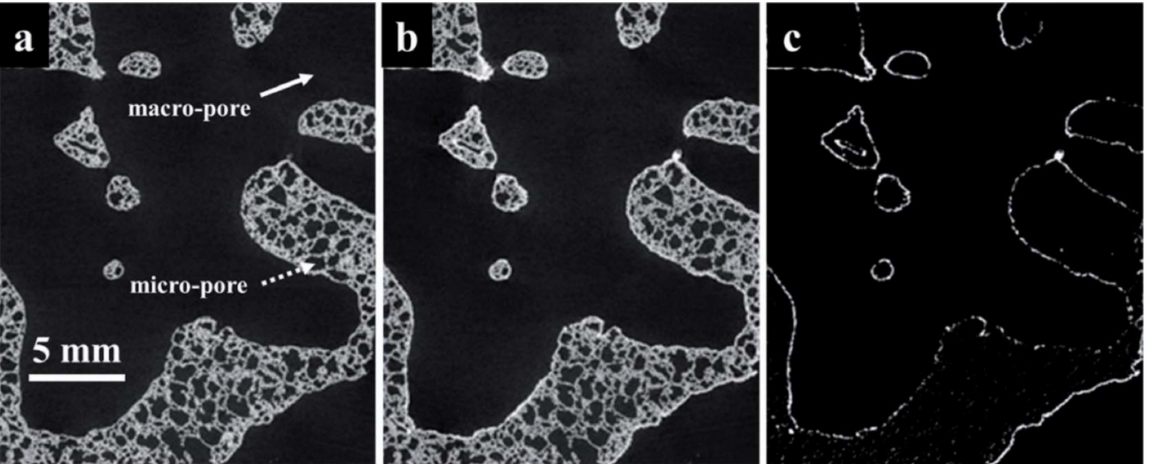
Figure 12. The 2D tomogram slices of a porous SiC sample with dual-scale pore sizes including macro pores between struts and µ m-sized micropores inside struts; ( a ) before; ( b ) after LCMA perovskite coating; and ( c ) after tomograms’ registration showing the perovskite mapping [136]. Haeussler et al. [73] tested a series of ceria RPCs with gradient pore sizes in the range of 10–60 ppi within a 1.5 kW th directly irradiated solar reactor. The temperature-swing RedOx reactions were performed (TR: 1400–1450 ◦ C and WS/CDS at 700–1100 ◦ C) to produce pure H 2 or CO inside the same reactor (Figure 13). Similarly, the results demonstrated that the degree of ceria reduction increases with decreasing of both the temperature and the operating pressure. Moreover, it was found that the oxidation rate could be improved (up to 9.3 mLg − 1 min − 1 ) by increasing the inlet CO 2 flow rate which is attributed to the increasing of the reactions driving force. A maximum η solar-to-fuel of ~7.5% was also measured after 64 cycles with a high stability of the porous RedOx structures [73].